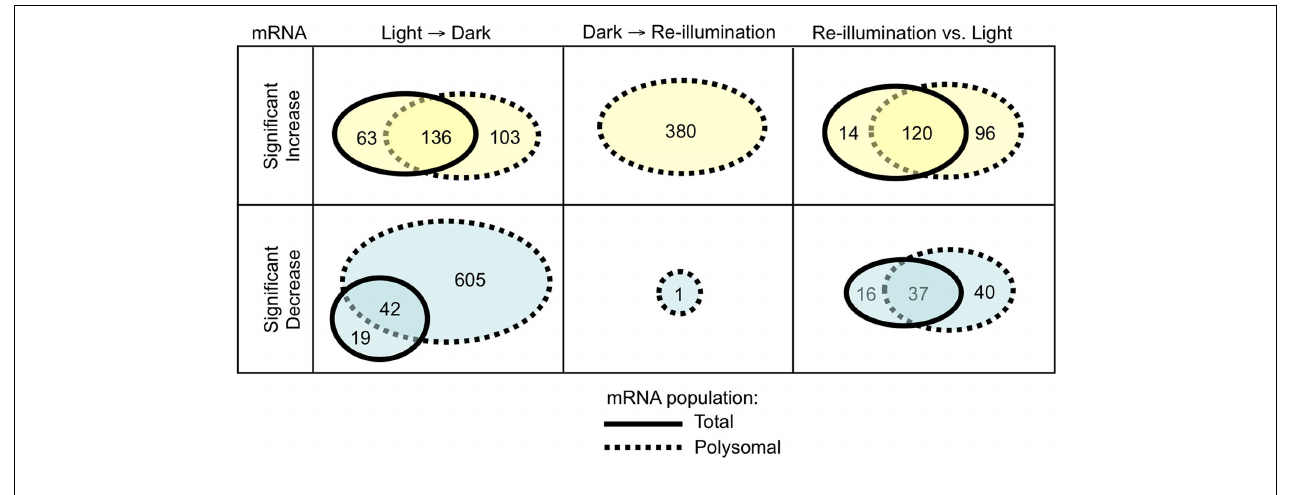
those without all “absent” calls in the bioreplicates and with a significant increase or decrease in abundance in total or polysomal mRNA (|SLR| ≥ 1; FDR < 0.05; n = 1224 probe pair sets). Dark/Light (L → D), Re-illumination/Dark (D → R), and Re-illumination/Light (R versus L).